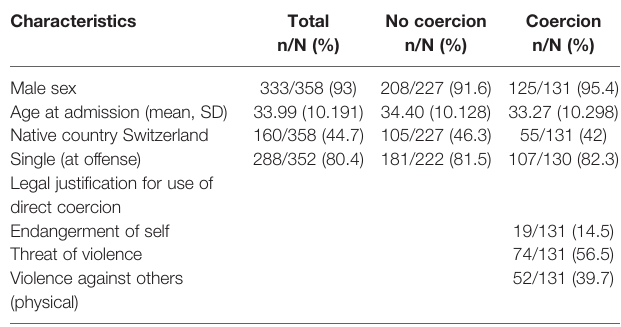
TABLE 1 | Sociodemographic characteristics of the studied sample and legal justi fi cations for use of direct coercion. Characteristics